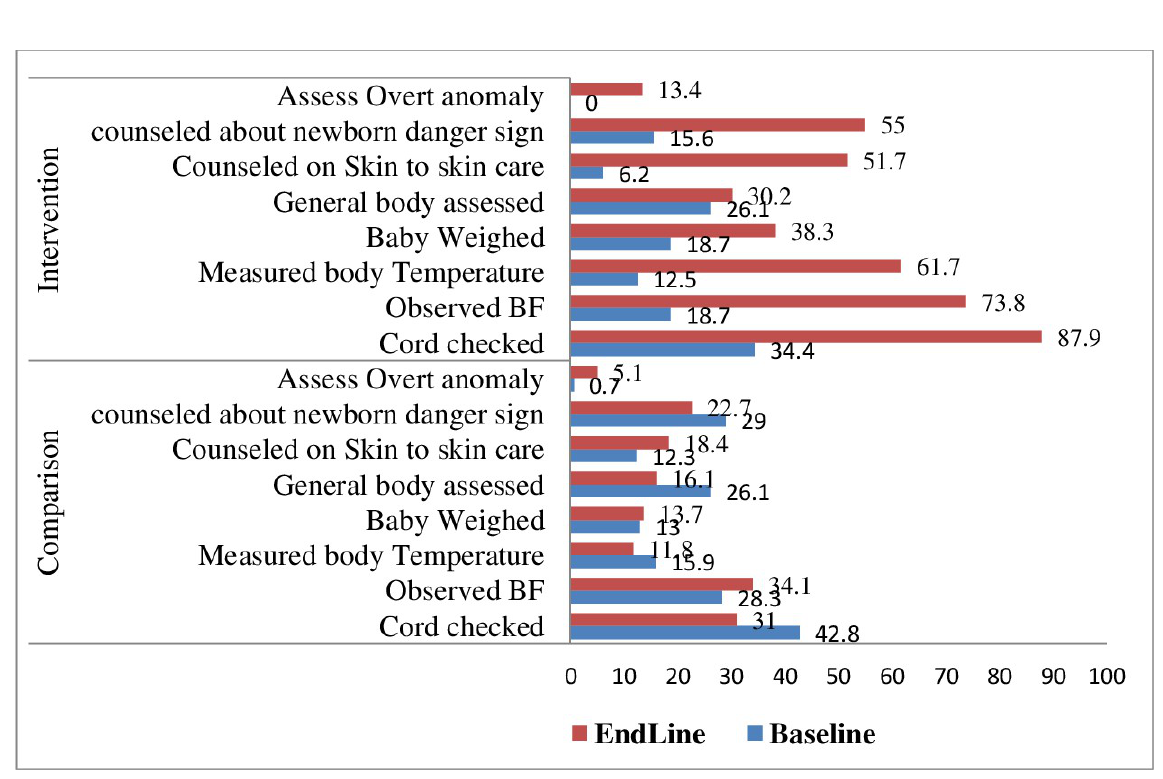
Diff = Single difference.